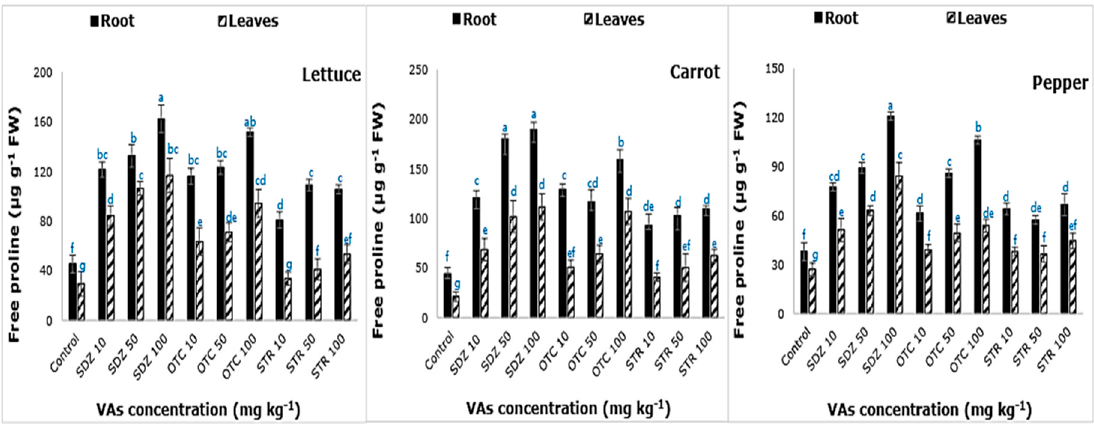
Figure 4. Mycorrhizal frequency of lettuce, carrot, and pepper grown in soil treated with VAs. Error bars represent standard error. Concentration values followed by different letters are significantly different ( p < 0.05) according to Duncan’s multiple range test. SDZ = Sulfadimethoxine; OTC = Oxytetracycline; STR = Streptomycin.